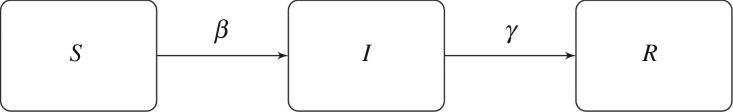
The transition of individuals between susceptible, infected and recovered states in an epidemiological compartmental model.